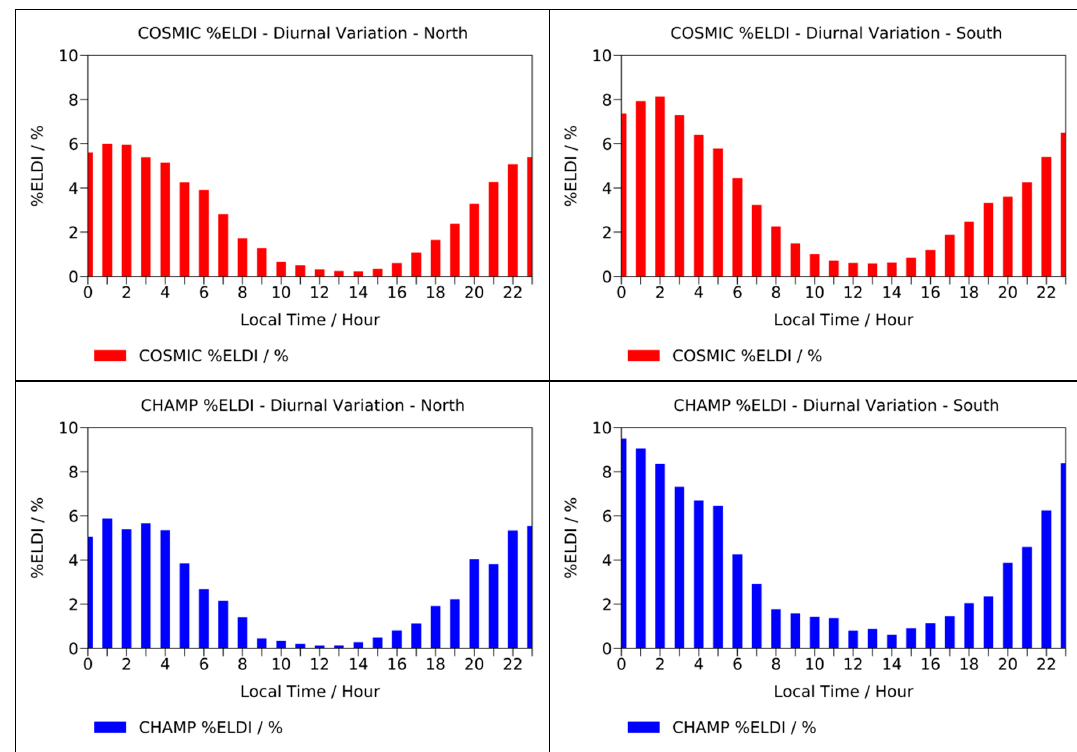
Figure 6. Diurnal variation of %ELDI. ( Top panels ) COSMIC (data from 2006 to 2018); ( bottom panels ) CHAMP (data from 2001 to 2008). ( Left panels ) northern high latitude region; ( right panels ) southern high latitude region.